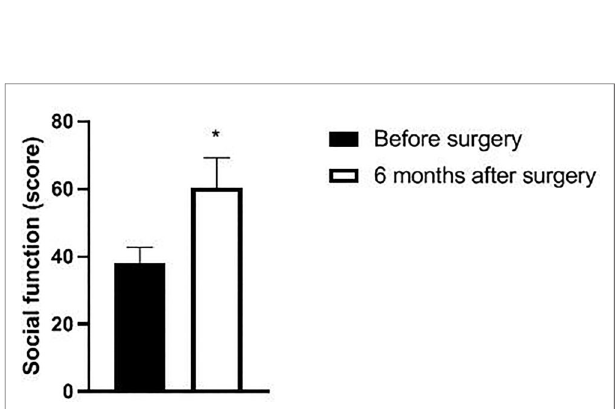
FIGURE 6 | Changes in social function scores of patients before and after surgery.